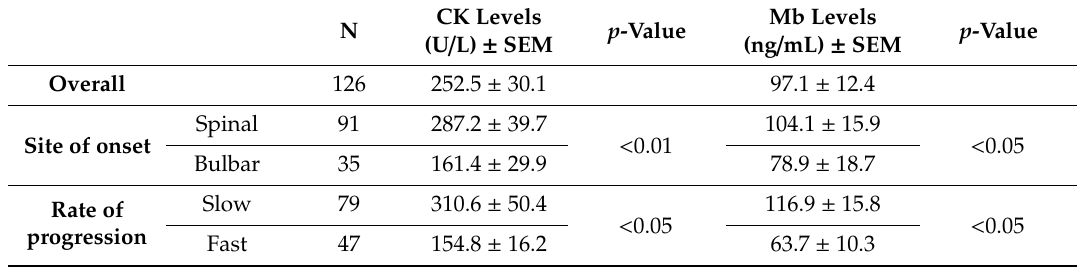
Table 2. Baseline creatinine kinase (CK) and Myoglobin (Mb) in amyotrophic lateral sclerosis (ALS) by site of onset and rate of progression.